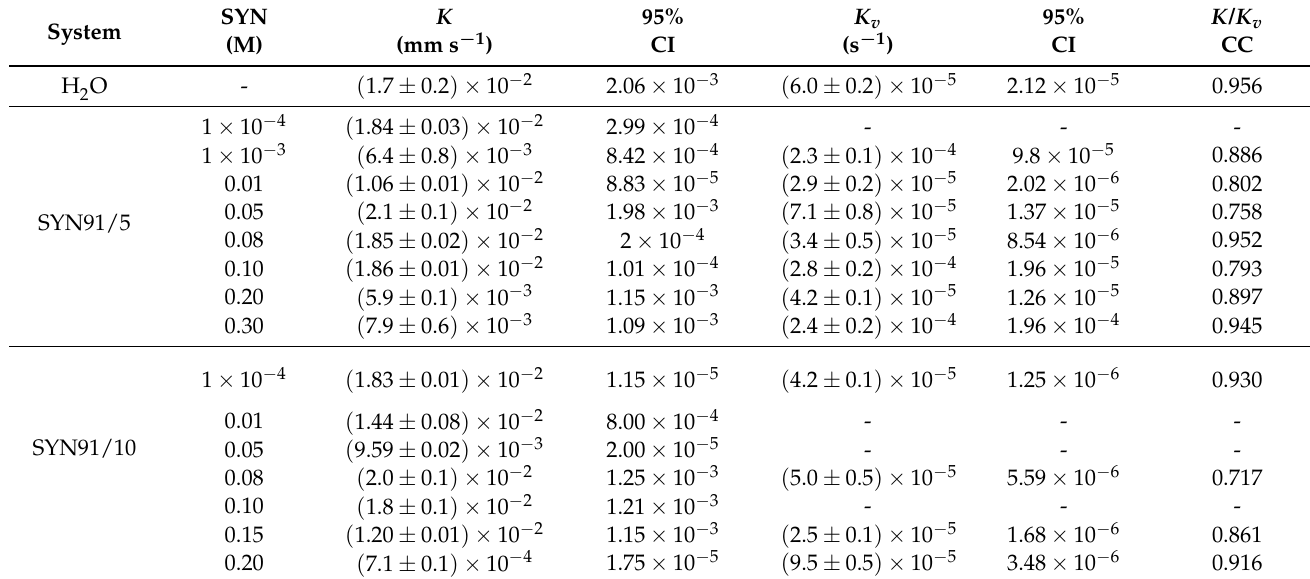
Table A2. Mass transfer coefficients K and volatilization coefficients K v at different concentrations of SYN/X (CI, confidence interval; CC, correlation coefficient).